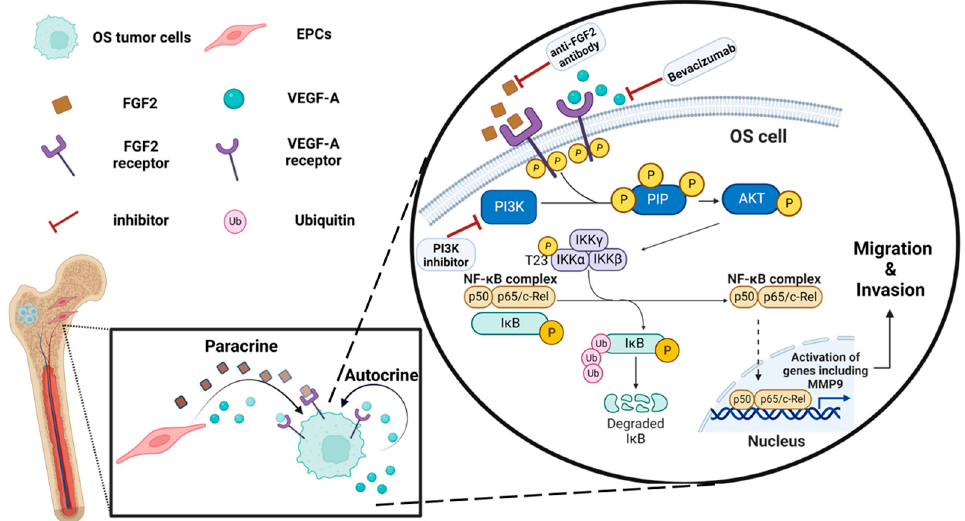
Figure 5. Proposed schematic illustration of the molecular mechanisms of the OS-EPC interaction: EPCs promote OS migration and invasion via the PI3K/AKT signaling pathway. EPCs secrete VEGF-A and FGF2 that activate, in a paracrine manner, PI3K/AKT signaling in OS cells, leading to upregulation of metastasis-related genes, including MMP9. OS cells secrete VEGF-A, which activates the pathway in an autocrine manner. PI3K inhibitor, FGF2 antibody, and Bevacizumab attenuate OS cell migration by inhibiting this pathway. The illustration was created with